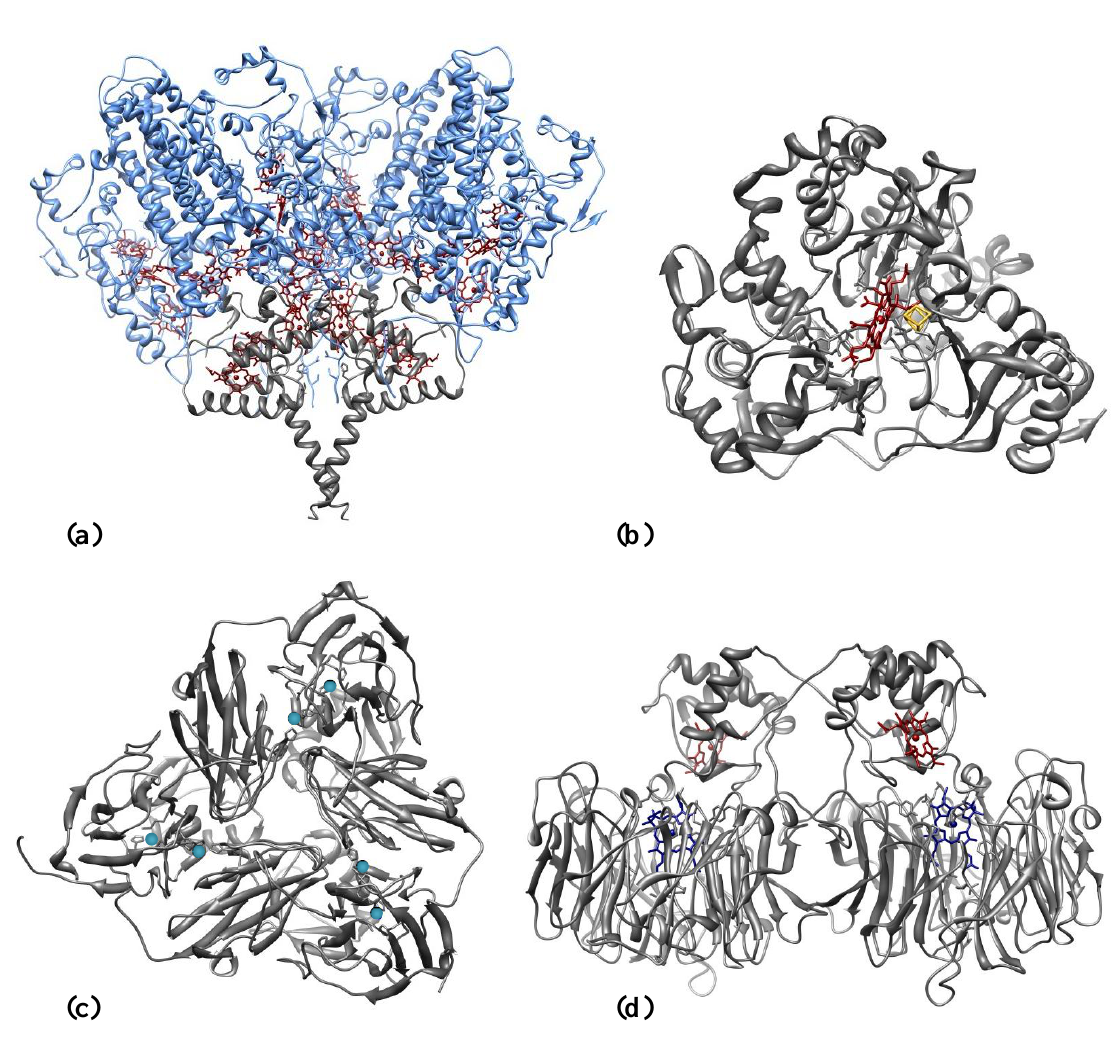
Figure 3. Three-dimensional structures of nitrite reductases. (a) Desulfovibrio vulgaris Hildenborough multiheme c nitrite reductase (NrfA NrfH complex); the catalytic subunit 4 2 (NrfA) is depicted in blue and the electron donor subunit (NrfH) in gray; heme groups are shown in dark red [65]. (b) Spinach nitrite reductase; siroheme is shown in dark red and iron-sulfur cluster in yellow [70]. (c) Achromobacter cycloclastes copper nitrite reductase (trimer); the copper centres are shown in blue [71]. (d) Pseudomonas aeruginosa cytochrome cd nitrite reductase (dimer); heme c is depicted in dark red and heme d in 1 blue